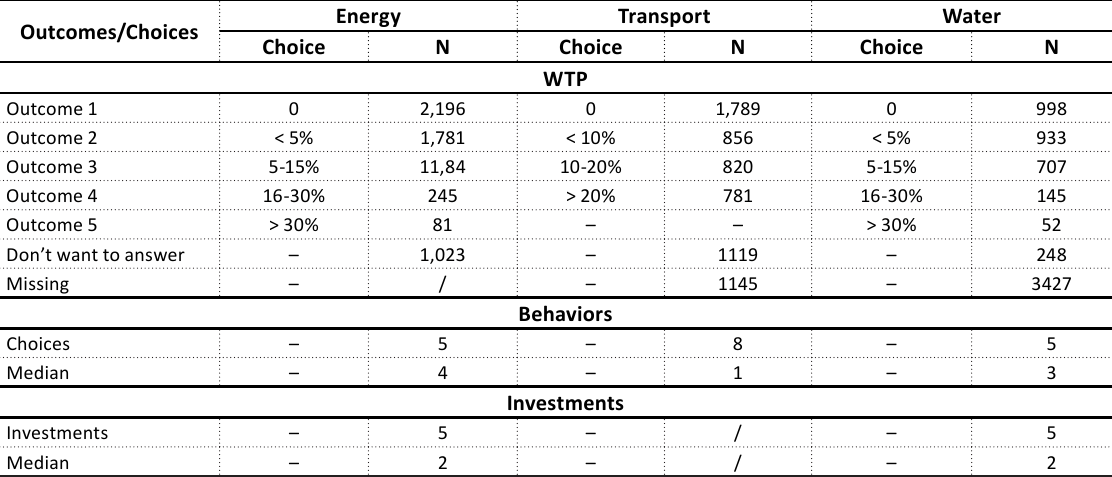
Table 3. Frequencies and medians for variables related to pro-environmental goods and behaviors in each of the domains, namely energy, transport and water